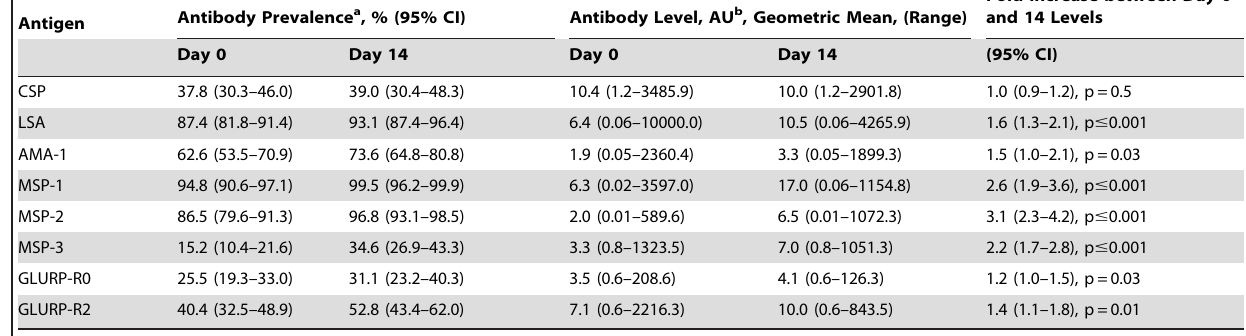
Table 1. Antibody responses to Plasmodium falciparum antigens.